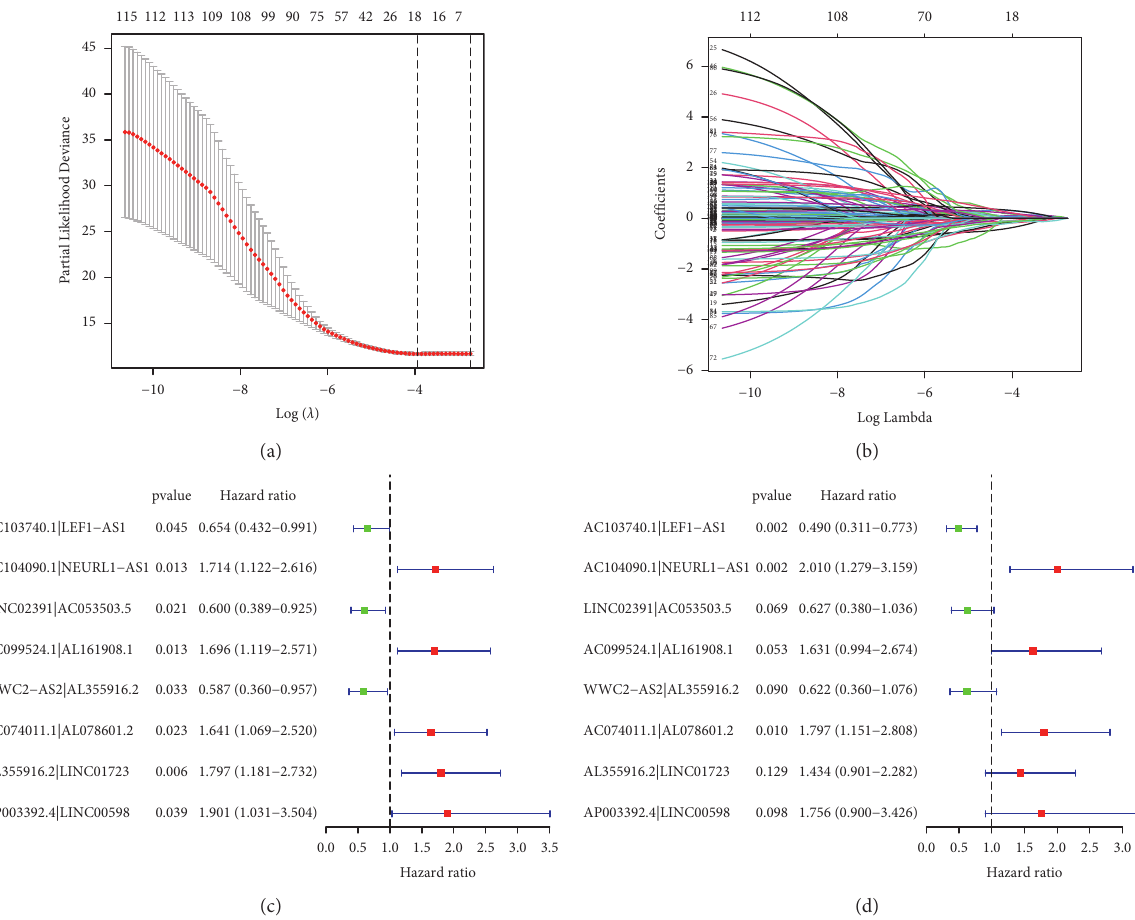
Figure 3: Construction of an irlncRNA signature. (a) λ selection by 10-fold cross-validation. The value 0.019 was chosen for λ by 10-fold cross-validation with the minimum criteria. (b) Processes of LASSO Cox model fitting. (c) Univariate and (d) multivariate analysis of the influence of DEirlncRNA pairs in colon cancer ( P � 0 . 010; Figure 7(l)), HLA ( P � 0 . 031; Figure 7(m)), iDCs ( P � 0 . 009; Figure), Mast_cells ( P < 0 . 001; Figure 7(o)), Figure 7(p)), Neutrophils ( P � 0 . 023; Figure 7(q)), Parainflammation ( P � 0 . 009;